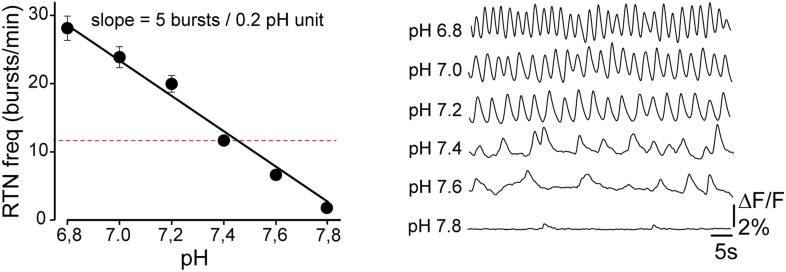
DOI:
http://dx.doi.org/10.7554/eLife.07051.018